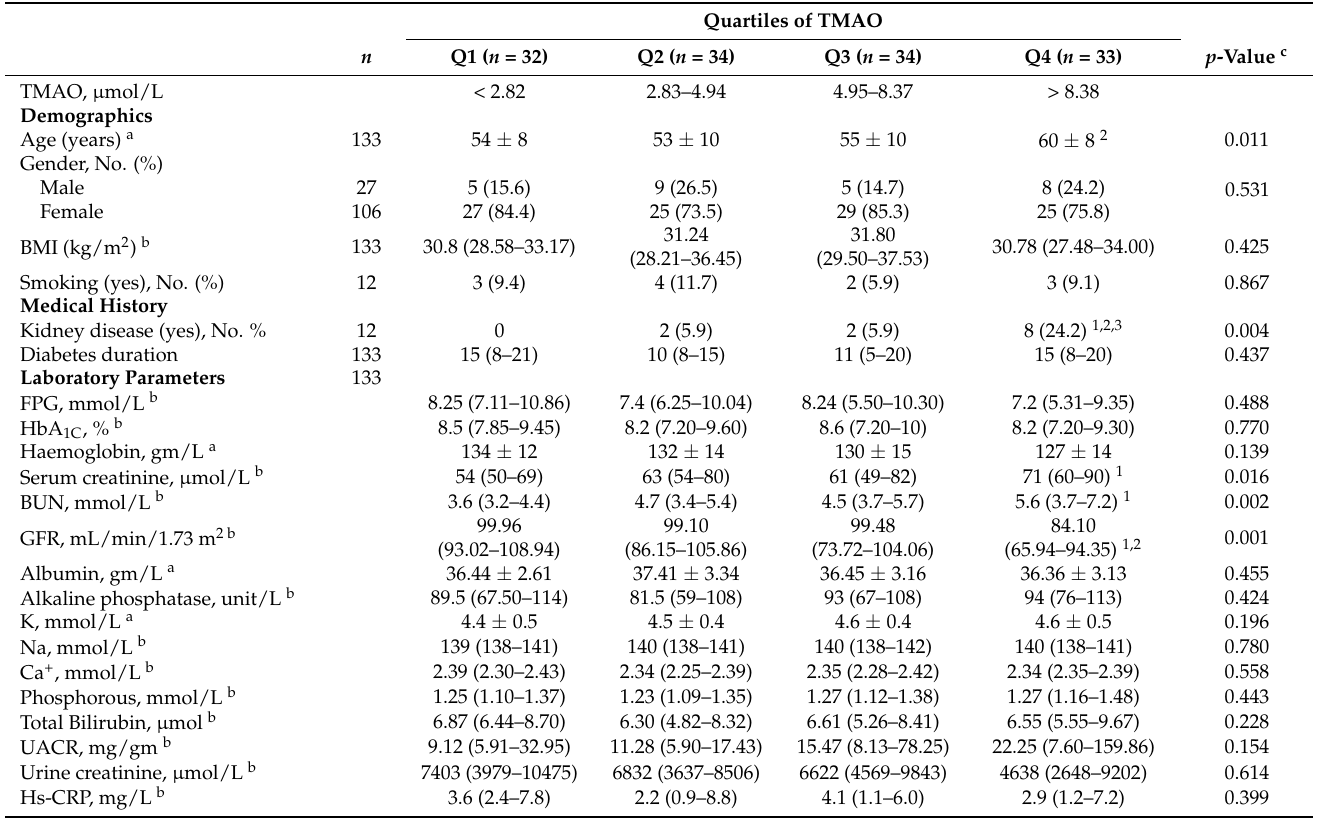
Table 2. Participant characteristics by quartiles of TMAO levels.